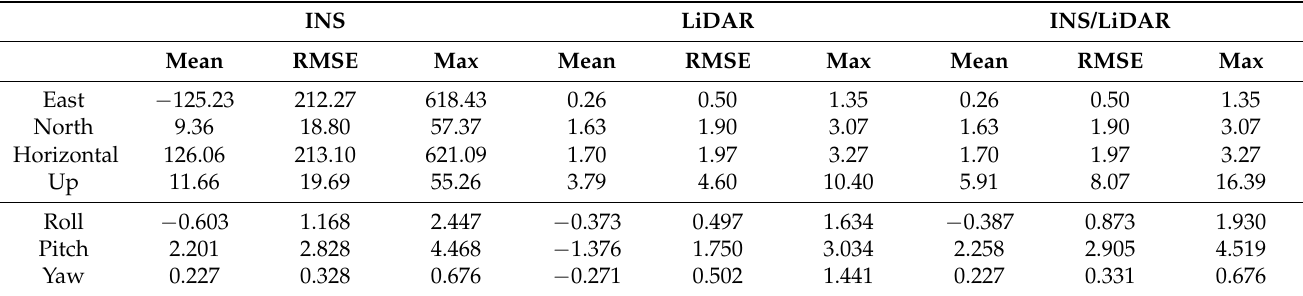
Table A13. D-61—position (m) and attitude (deg) error